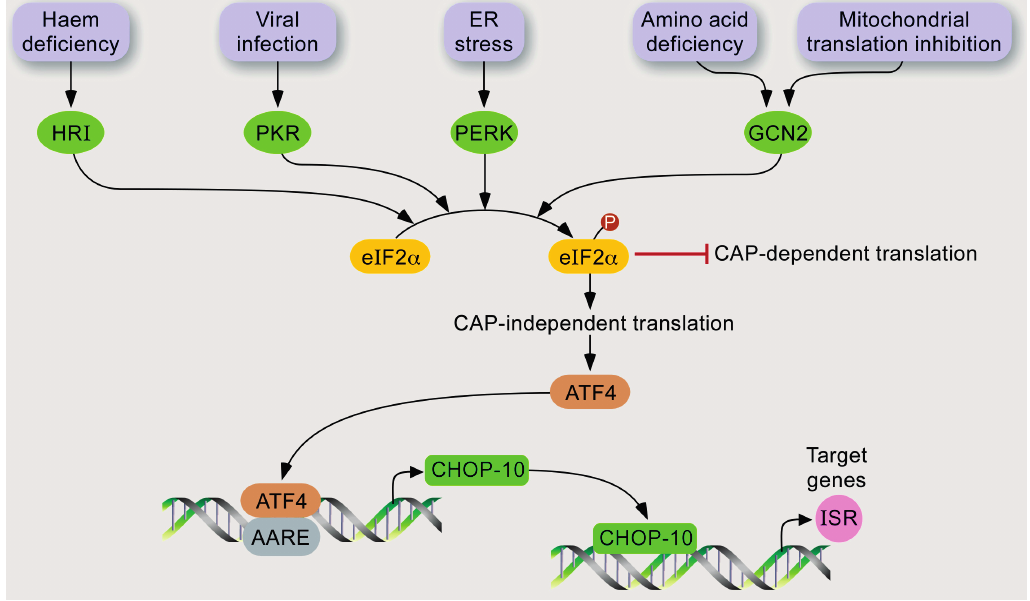
Figure 2. Hypothetical model for stress response to mitochondrial dysfunction. In